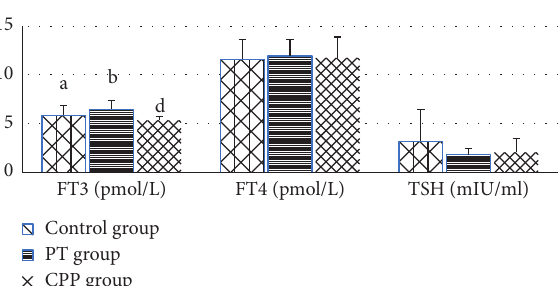
Figure 3: Comparison of thyroid hormone among the three groups. Values are expressed as the mean ± SD. “A” represents comparison among the three groups, P < 0 . 05; “B” represents comparison between PTand controls, P < 0 . 05; “C” represents comparison between CPP and controls; “D” represents comparison between CPP and PT, P < 0 .